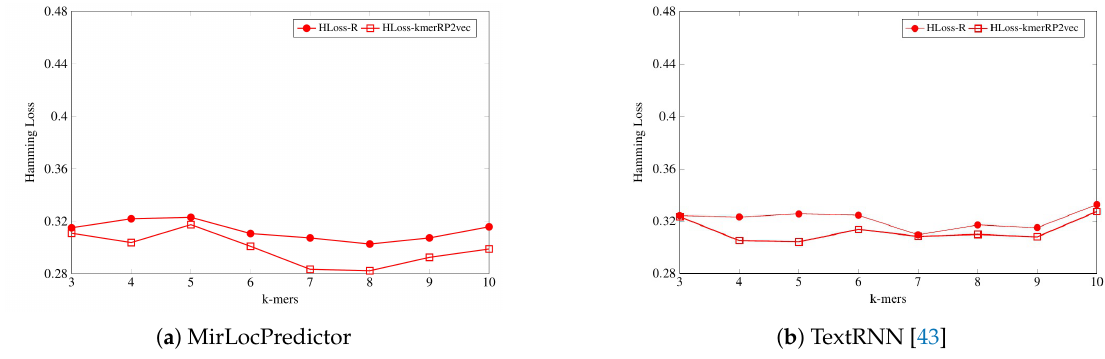
Figure 6. Hamming loss of the proposed kmerPR2vec and randomly initialized k-mer embeddings at 8 benchmark k-mers using two classification